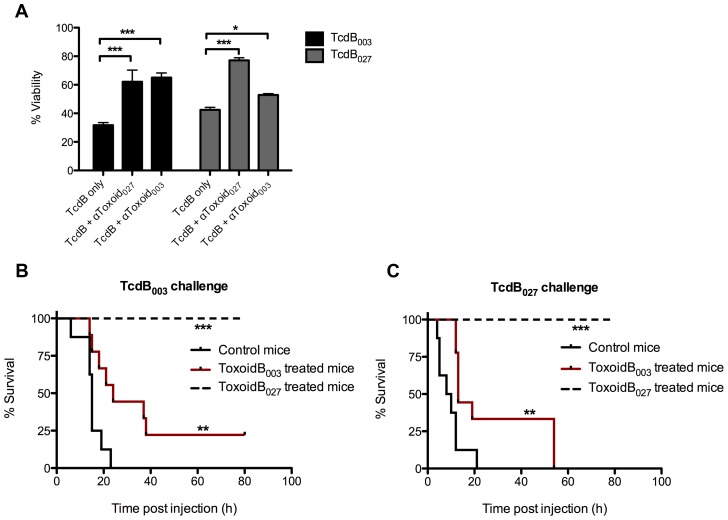
Protection against TcdB in vivo and in vitro after immunization with ToxoidB027.(A) Percent viability of CHO cells treated for 24 hrs with TcdB003 (black) or TcdB027 (gray) alone or after preincubation for 30 minutes with αToxoidB003 antiserum or αToxoidB027 antiserum. Cell viability was determined by WST-8 staining and the error bars represent the standard deviation from the mean of three samples. ***p<0.001, *p<0.05 (B–C) Kaplan-Meier graphs showing the time to death of C57Bl/6 mice that were injected intravenously with a 2×LD100 of TcdB003 (A) or TcdB027 (B) after immunization with ToxoidB003 (red), ToxoidB027 (dashed), or control peptide (black) (n = 9). Log-rank analysis performed using GraphPad Prism, *** p<0.001, ** p<0.01.